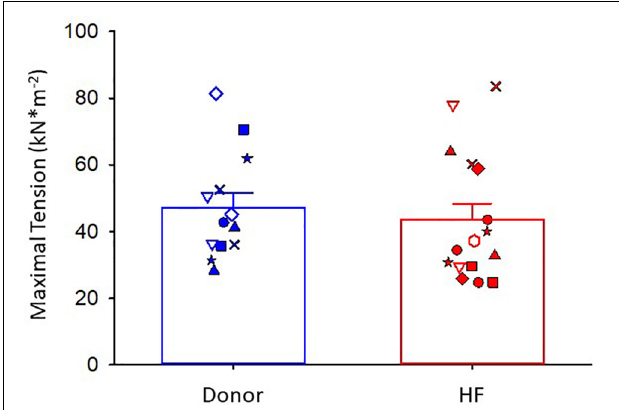
FIGURE 3 | Rate of force development ( k tr ) during maximal Ca 2 + activation. Donor group, N = 6 hearts, n = 11 cardiac myocyte preparations. HF group, N = 8 hearts, n = 14 cardiac myocyte preparations. Different symbols indicate data points from each heart sample. Linear mixed model, p = 0.663.